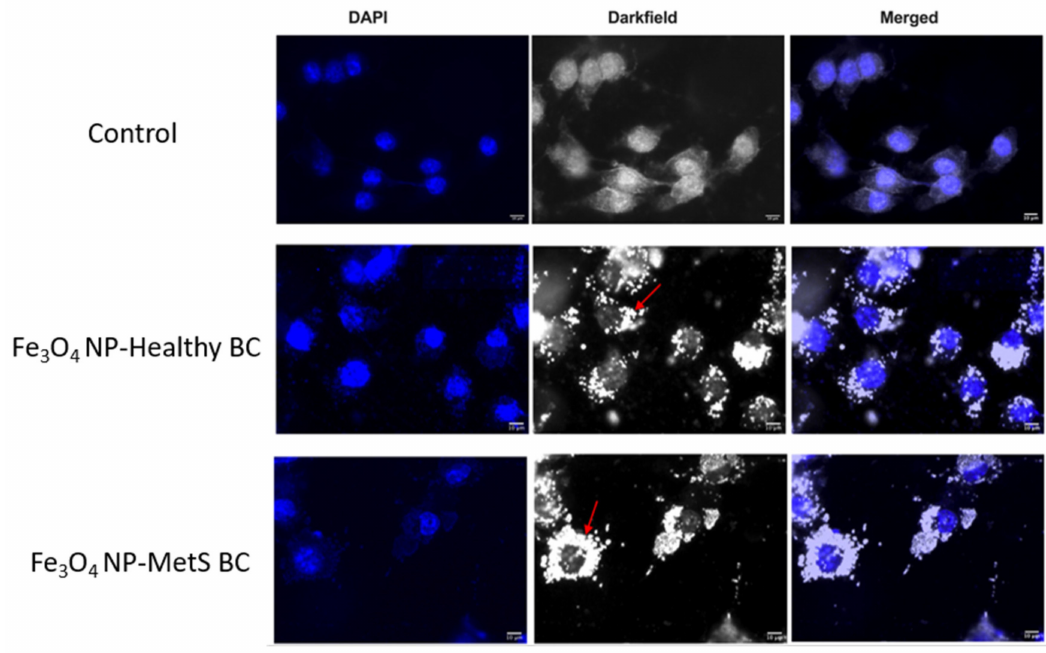
Figure 7. Assessment of cellular association of Fe 3 O 4 NPs by dark-field microscopy. Representative images of internalized Fe 3 O 4 NPs in control, healthy BCs, and MetS BCs groups. Bright dots labeled with red arrows indicate distribution of Fe 3 O 4 NPs in